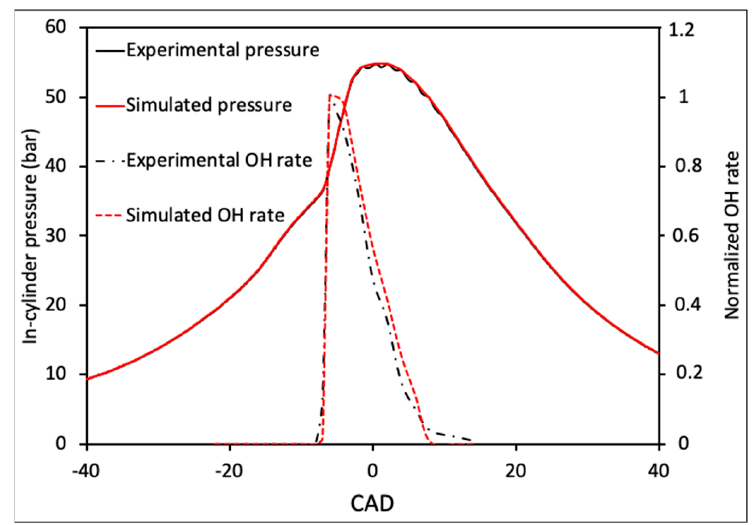
Figure 11. Experimental and numerical of OH radical rates comparison when the injection pressure is equal to 700 bar and engine speed fi xed at 2000 rpm.